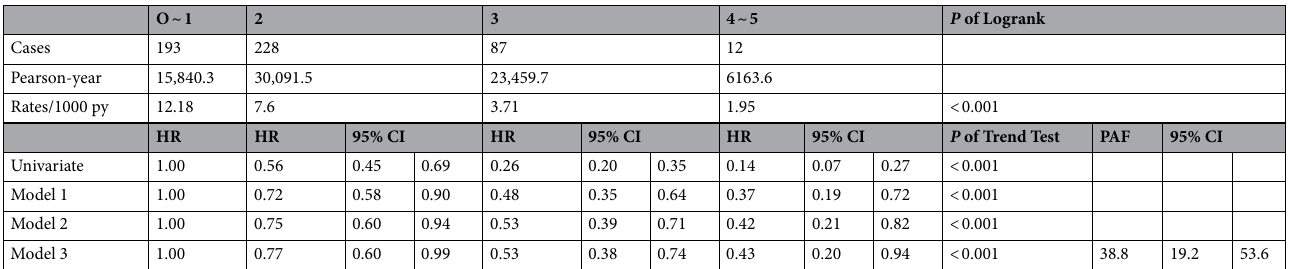
Table 2. The incidence cases, follow-up person-years, and rates of cardiovascular disease events according to lifestyle factors, hazard ratios, and 95% confidence intervals specified by the simple Taiwan healthy lifestyle score, according to the numbers of the score. Model 1: adjusted for age and sex; Model 2: Model 1, additionally education, average month income, marital status, parental history of CVD, menopause status and estrogen exposure; Model 3: Model 2 + baseline HTN, baseline DM, history of hyperlipidemia, sBP, dBP, triglyceride, non-HDL, fasting glucose, HbA1c; The population attributable risk is the percentage of new cases of heart failure in the population attributable to nonadherence to the low-risk lifestyle